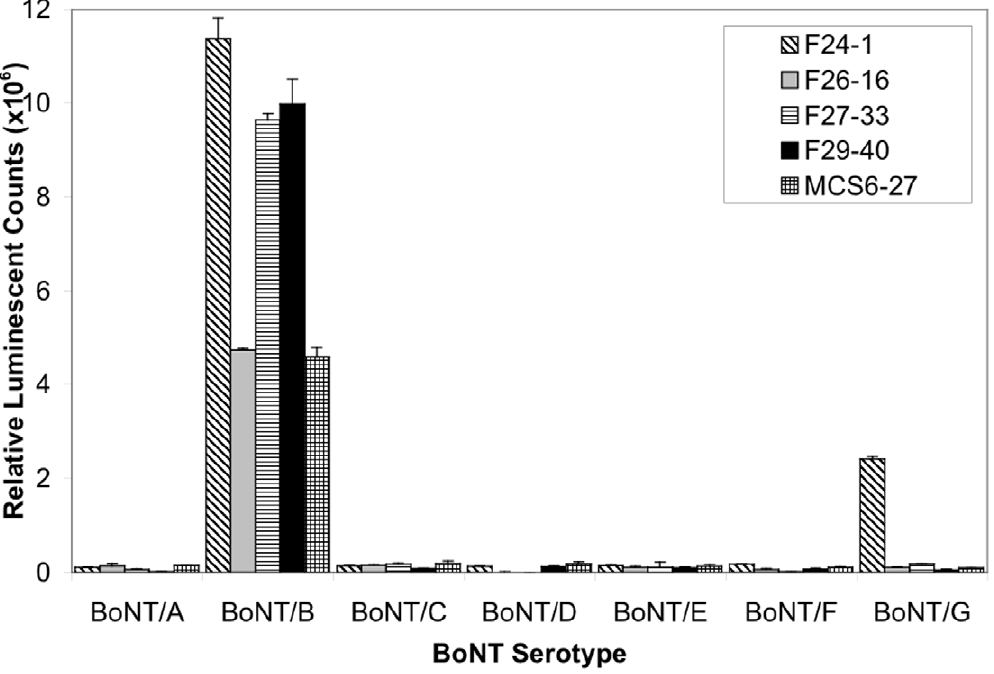
Figure 3. Antibody binding to BoNT serotypes by direct binding ELISA. Antibody binding to black microtiter plates coated with 0.1 m g/mL solutions of BoNT serotypes A through G was measured. Data are presented as average of 3 samples 6 1 standard error.